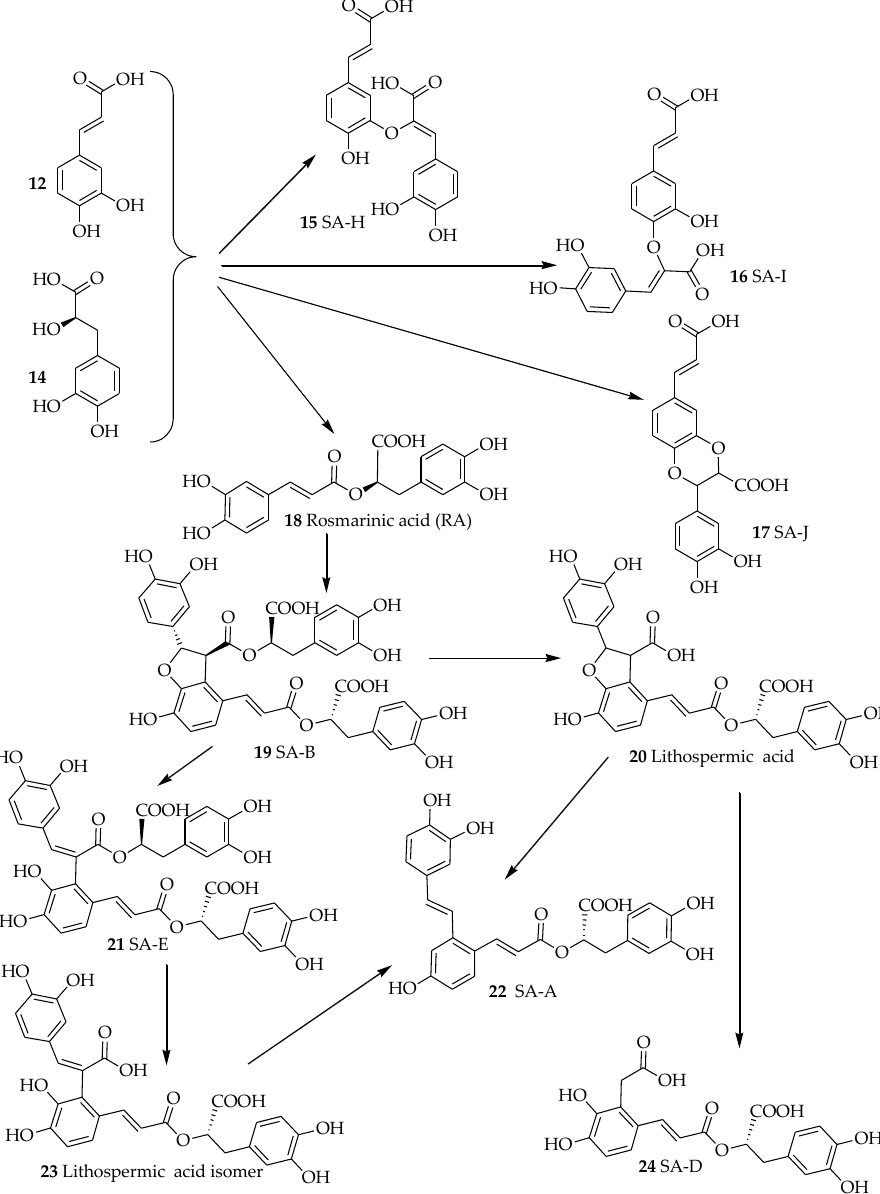
Figure 2. The routes of synthesis of salvianolic acids and related compounds. Following the synthesis of SA-B as dimeric RA, several oxidation and degradation reactions lead to diverse intermediates. Note that various stereoisomeric derivatives can also be obtained.